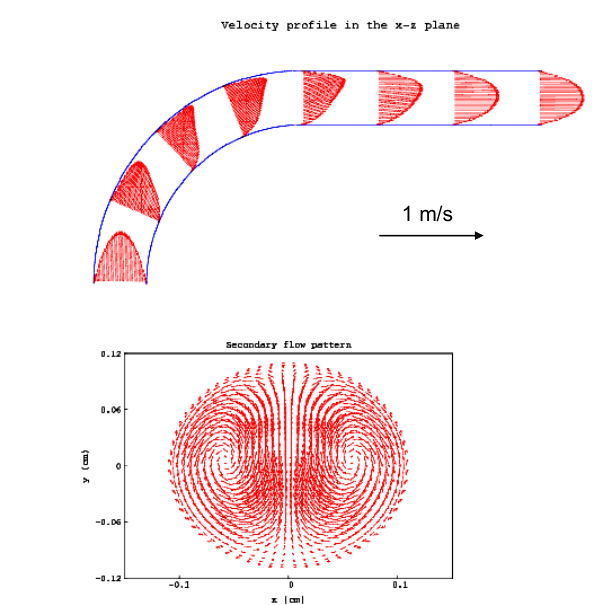
Fig. 6 Velocity distribution of the curved artery model. (a) longitudinal flow velocity field; (b) secondary flow in the cross